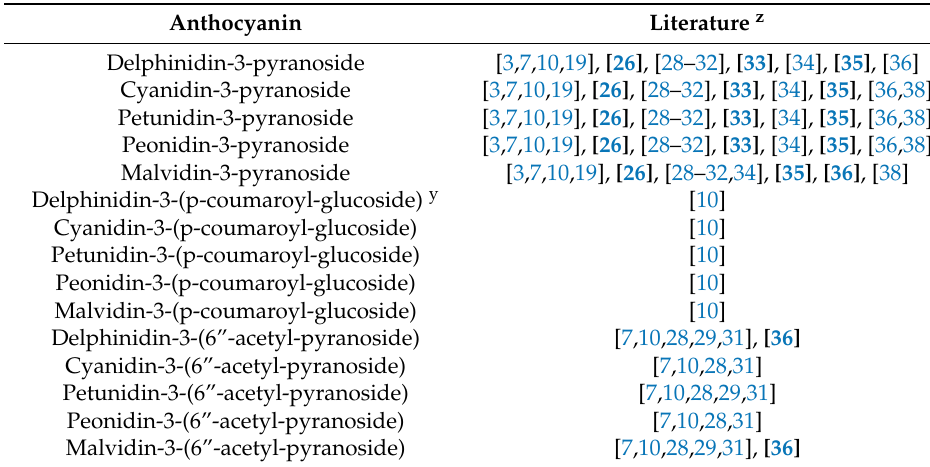
z References denoted by bold font indicate rabbiteye blueberry samples. y “p” indicates para